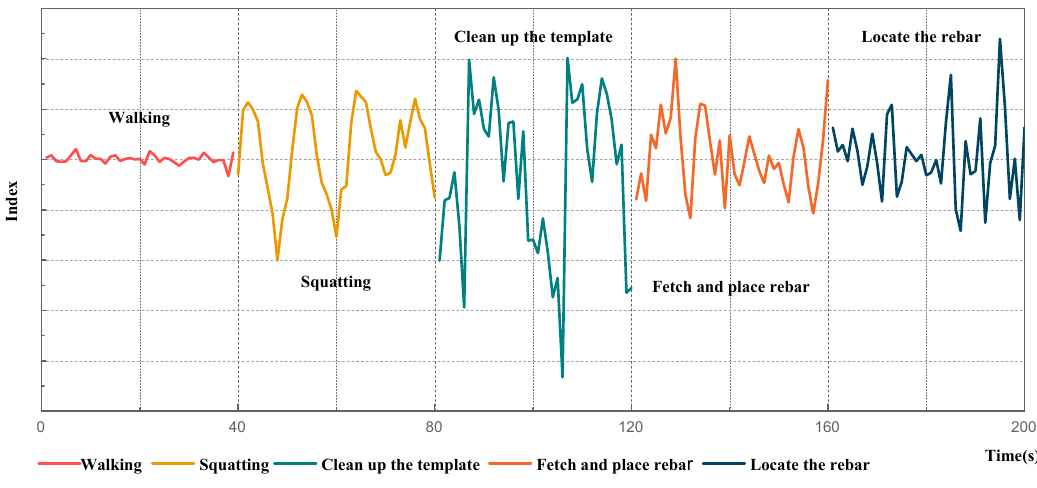
Figure 12. Visualization of construction process.